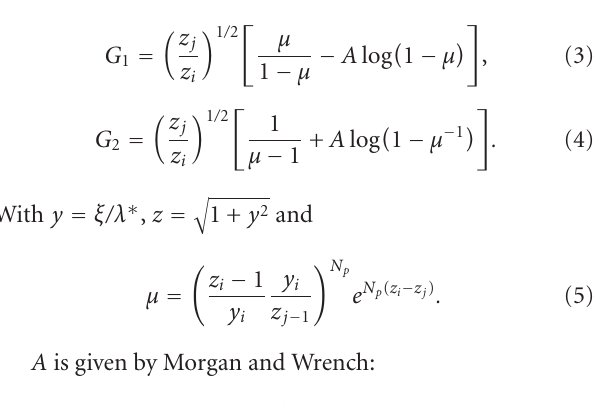
where G 1 and G 2 are given